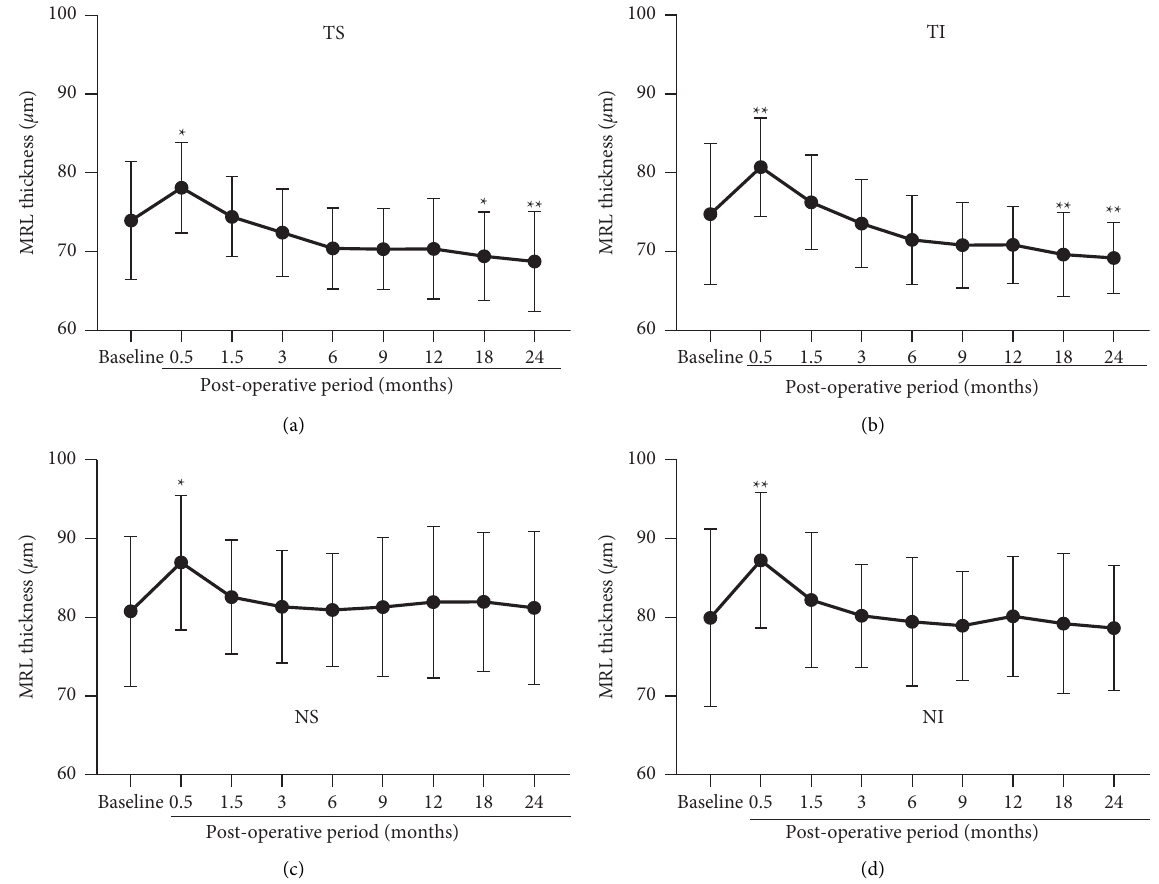
Figure 5: Mean thicknesses of the middle retinal layer (MRL) are plotted for the MH eyes treated with ILM peeling. In the temporal/ superior (a), temporal/inferior (b), nasal/superior (c), and nasal/inferior quadrants (d), the MRL of the treated eyes is thicker at 0.5 months with significant difference from that of the baseline (preoperative eyes). In the temporal quadrants, the MRL is thinner with significant difference from that of the baseline after the month 18. MH, macular hole; ILM, internal limiting membrane; TS, temporal/superior; TI, temporal/inferior; NS, nasal/superior; NI, nasal/inferior. Asterisks represent significant differences between the control and operated eyes. ∗ P < 0 . 05, ∗∗ P < 0 .